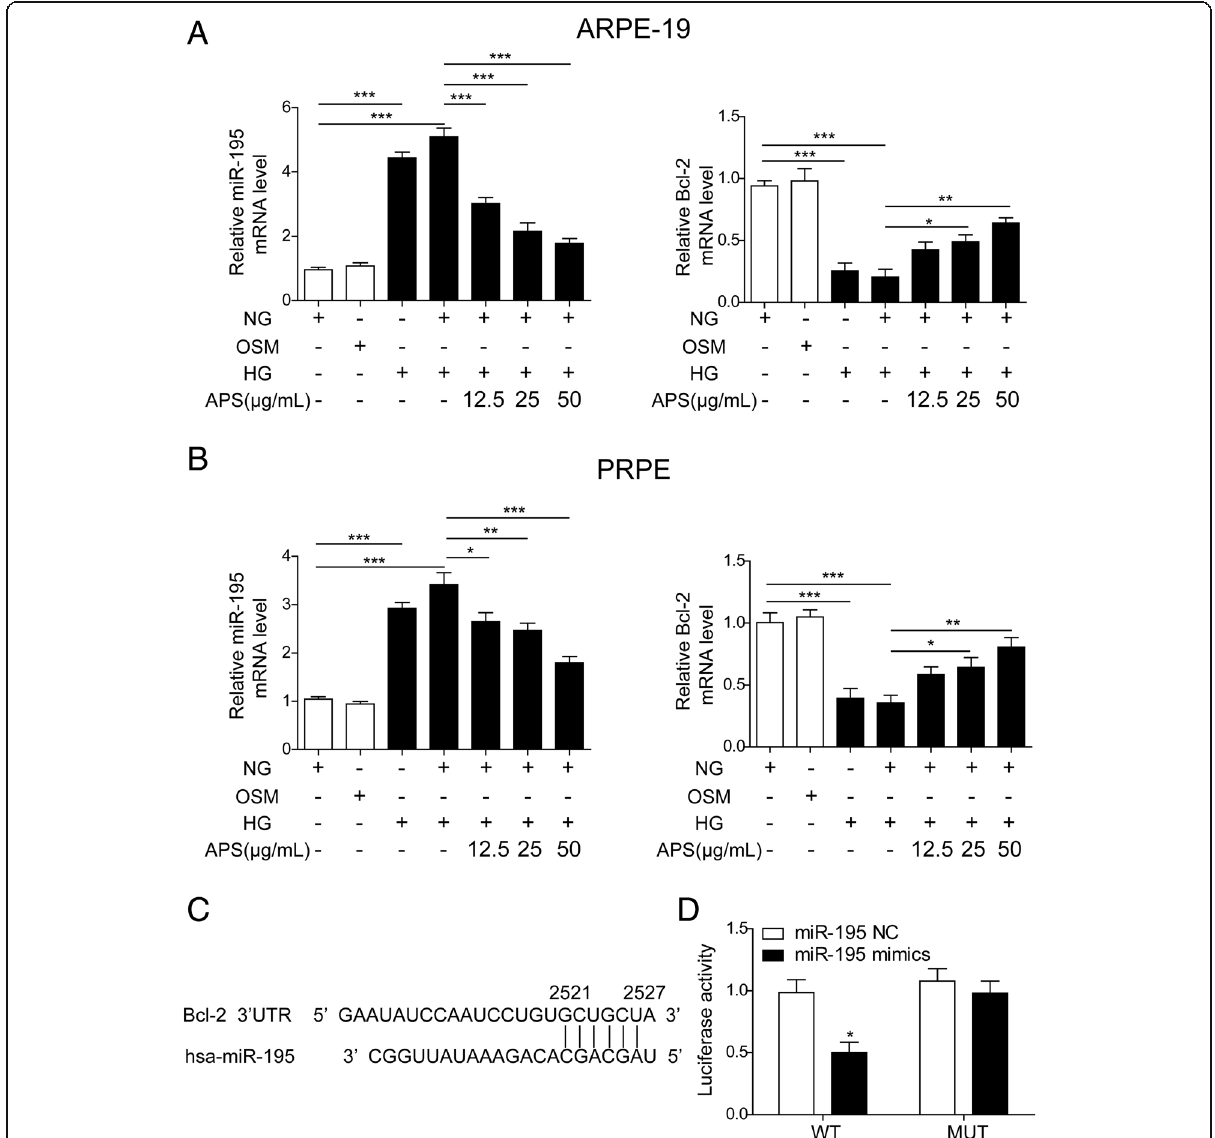
Fig. 2 APS inhibited the high glucose-induced upregulation of miR-195. a Treatment with APS significantly decreased the expression of miR-195 and increased the expression of Bcl-2 which were induced by HG or HG + NG treatment in ARPE-19 cell line. b Treatment with APS significantly decreased the expression of miR-195 and increased the expression of Bcl-2 which were induced by HG or HG + NG treatment in PRPE cells. c Sequence analysis result showed miR-195 directly targeted to the 3 ’ UTR of Bcl-2. d Dual luciferase reporter assay showed miR-195 repressed the luciferase activity which contained the WT Bcl-2 3 ’ UTR, but not the mutant Bcl-2 3 ’ UTR. Error bars represented mean±SD. *** p <0.001, ** p